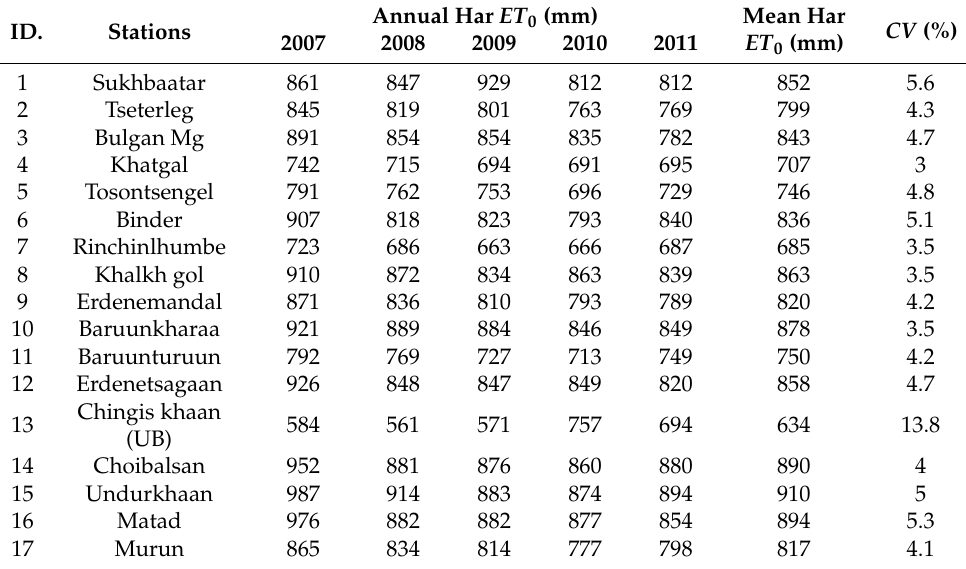
Table A2. Annual sums of ET 0 over the 41 weather stations in Mongolia.